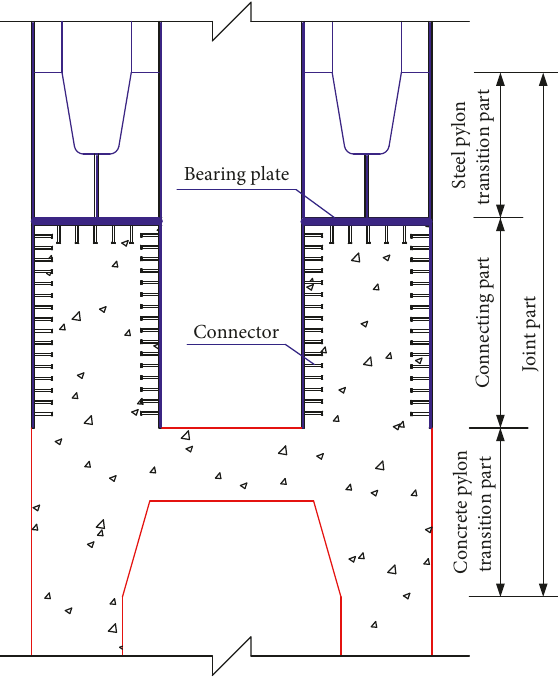
Figure 2: Schematic view of the hybrid joint